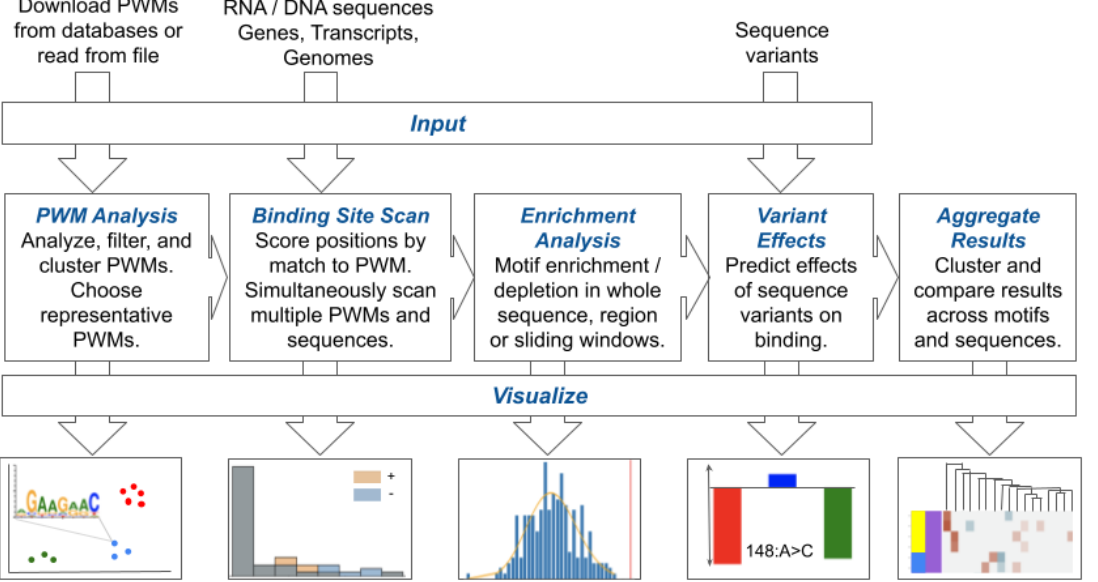
Figure 1. SMEAGOL enables the investigation of regulatory binding motif enrichment and variant effects in viral genomes. SMEAGOL takes as input sequence files in FASTA format and regulator binding specificities in the form of position weight matrices (PWMs) in order to perform PWM analysis, sequence scanning, enrichment/depletion analysis, and variant effect prediction. Finally, SMEAGOL enables visualization of the results in various ways.